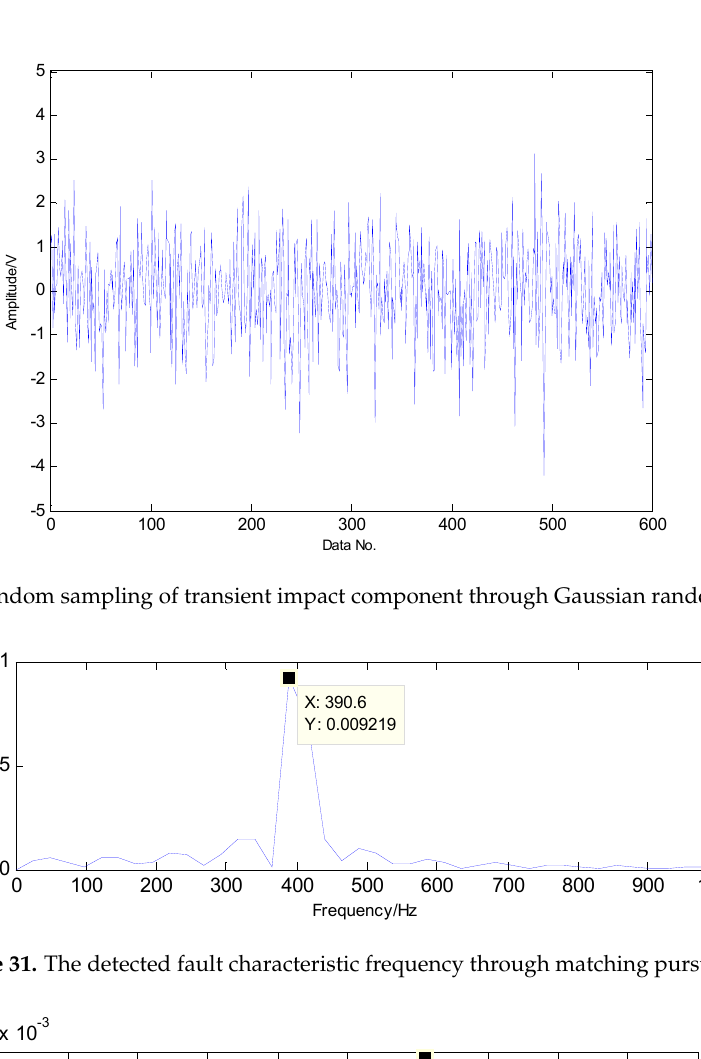
Figure 29. The transient impact component using TQWT.